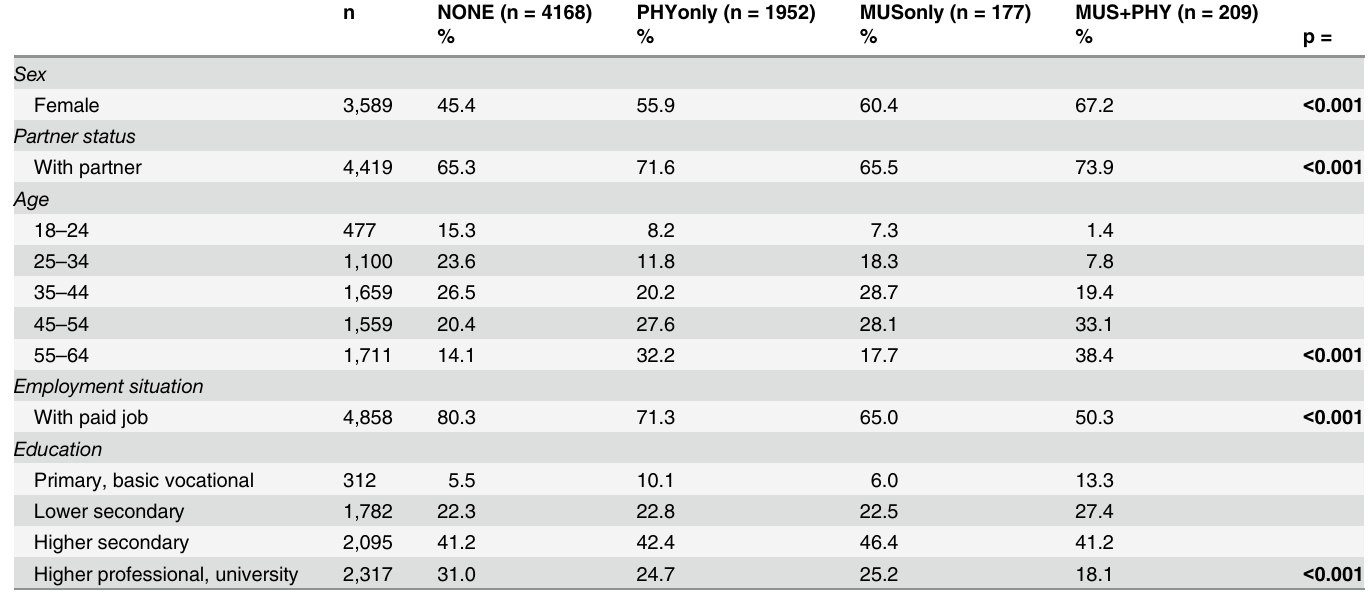
Table 2. Sociodemographic characteristics of subjects with and without MUS and explained physical symptoms (N = 6,506), in unweighted num- bers and weighted column percentages. n NONE (n =